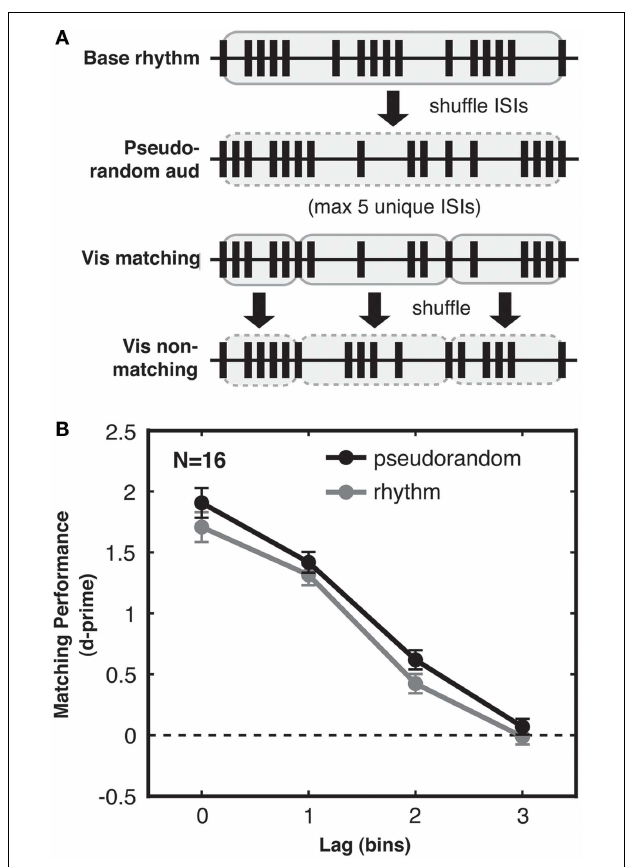
FIGURE 5 | Experiment 3: audio-visual correspondence sensitivity depends on sequence complexity, not merely ISI variability. (A) Generation of pseudorandom streams. From top to bottom: first, a base stream was generated as for rhythmic trials. All ISIs in this stream (highlighted in gray with solid outline) were then shuffled to create the pseudorandom auditory stream (shuffled ISIs highlighted in gray with dashed outline). Accordingly the distribution of ISIs was identical for pseudorandom and rhythmic streams.The matching visual stream (shown at lag 0 for simplicity here) was then divided into five-ISI bars (each highlighted in gray with solid outline). Each of these bars was then internally shuffled to generate the non-matching visual stream (shuffled bars highlighted in gray with dashed outline). Hence the relationship between the ISIs of the non-matching stream and the ISIs of the accompanying auditory and matching streams were the same for pseudorandom and rhythmic streams even at the bar-length timescale. In an information-theoretic analysis, this stream generation procedure resulted in pseudorandom and rhythmic streams with ISI distributions that had identical first-order entropies but still differed in second-order entropy, with more information in pseudorandom streams due to their more variable ISI transitional probabilities (see main text). (B) Matching performance was enhanced for pseudorandom streams (black) compared to rhythmic streams (gray), with only sequence complexity differing between streams in the two conditions, and higher complexity leading to better performance. Standard error of the difference between pseudorandom and rhythmic conditions is shown for each